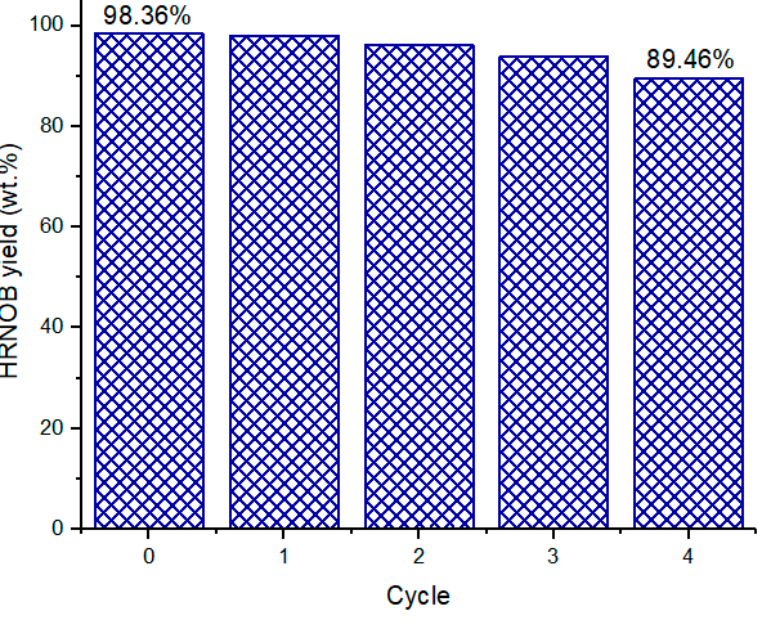
Figure 11. Reusability of calcined CPK at optimized condition.